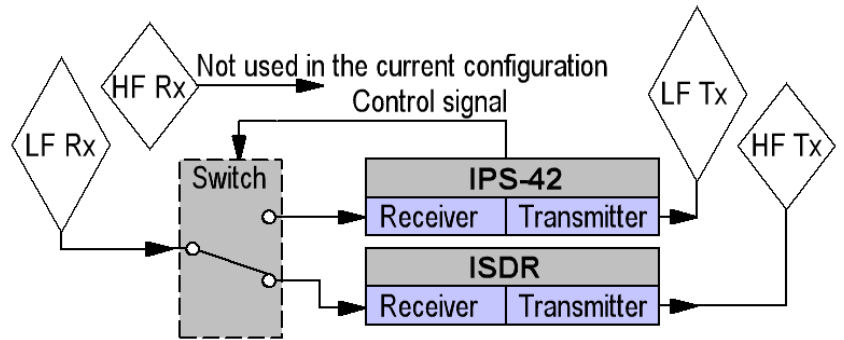
Figure 3. Schematic diagram of antenna connections.